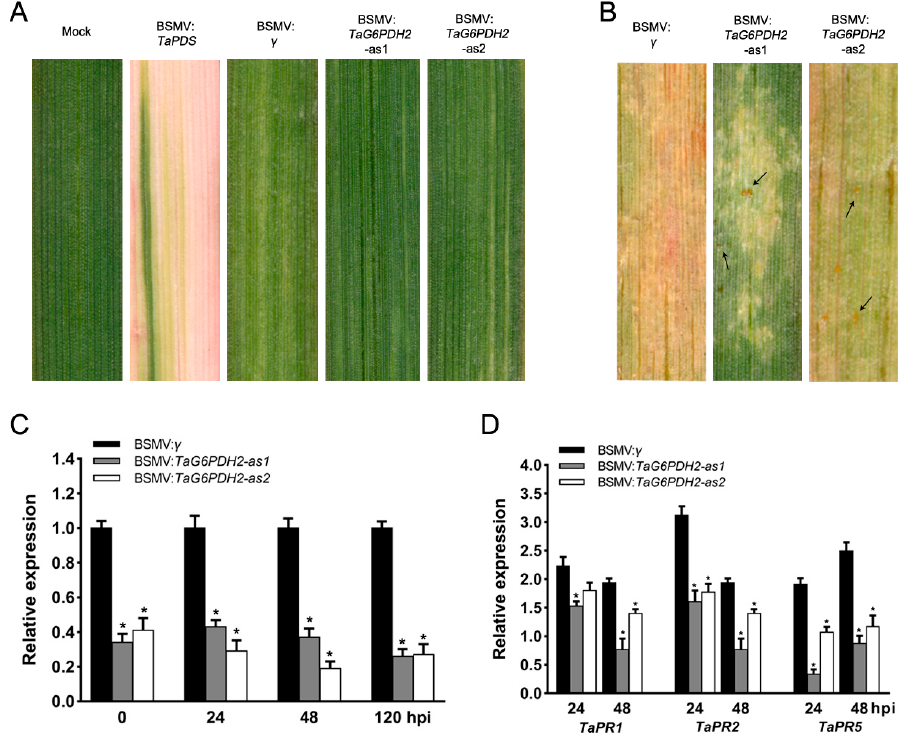
Figure 4. Silencing of TaG6PDH2 during the wheat– Pst interaction by the BSMV-VIGS system. ( A ) Viral symptoms of BSMV-inoculated wheat leaves at 13 dpi. Mild chlorotic mosaic phenotypes were found in wheat leaves inoculated with BSMV: TaG6PDH2-as1/2. BSMV: TaPDS -inoculated wheat leaves acted as a positive control. Wheat leaves inoculated with FES buffer and BSMV: γ were used as the negative control. ( B ) Disease symptoms of the BSMV-pretreated fourth leaves inoculated with Pst CYR23 at 12 dpi. Spores, indicated by arrows. ( C , D ) Relative transcript profiles of TaG6PDH2 , TaPR1 , TaPR2 , and TaPR5 in TaG6PDH2- silenced wheat compared with negative control. The Pst -CYR23-infected wheat leaves were sampled at 0, 24, 48, and 120 hpi. Ta EF was used as an internal control. Values indicate means ± SDs from three independent samples. Asterisks represent significant differences ( p < 0.05) according to Student’s t -test.